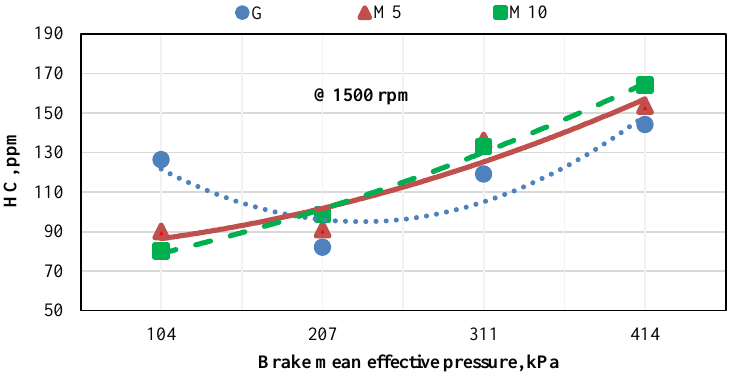
Fig. 7. HC emission for tested fuels at different